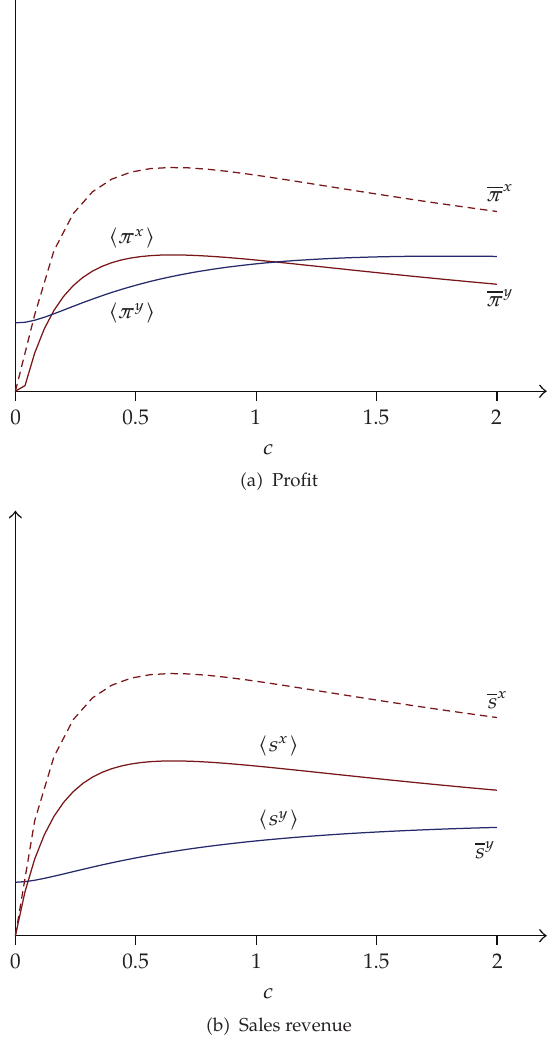
Figure 7: Performance measures under full-chaos (cid:2) γ (cid:6) γ max ,m (cid:6) 3 (cid:3) .